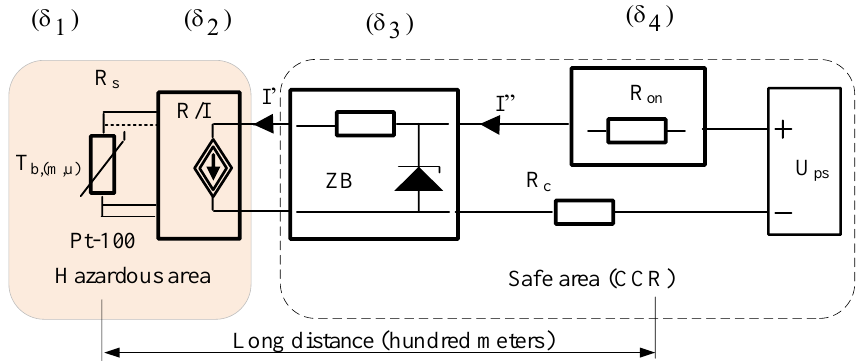
Figure 9. Functional diagram of temperature measurement line, where: R s —resistance of Pt-100 sensor, R / I—transmitter-source of current 4–20 mA sink type, ZB—Zenner barrier as the associated apparatus, R on —resistance of monitoring system, R c —equivalent resistance of cables, U ps —source of DC voltage, δ δ δ δ 1 , 2 , 3 , 4 are relative errors.